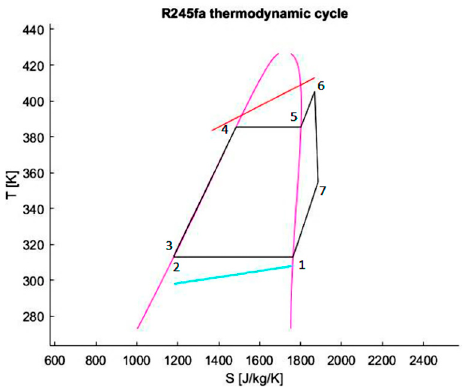
Figure 5. R134a T – S diagram. Figure 6. R245fa T – S diagram. Table 3. R134a thermodynamic parameters. Table 4. R245fa thermodynamic parameters.